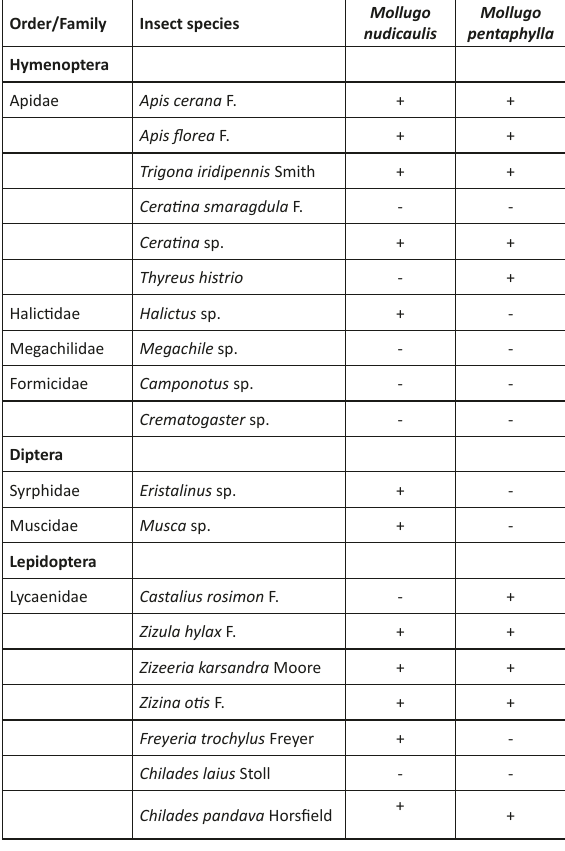
Table 2. List of insect foragers on Mollugo nudicaulis and Mollugo pentaphylla Order/Family Insect species